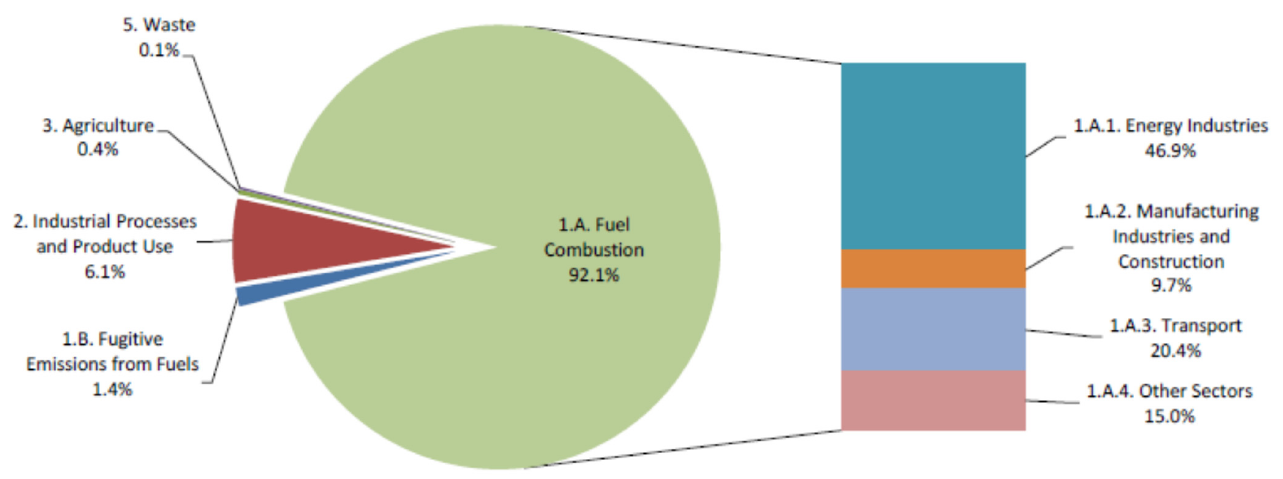
Figure 2. Carbon dioxide emission (in %) in Poland by sector (in 2019). Source: Poland’s National Inventory Report 2021 Greenhouse Inventory for 1988–2019 Submission under the United Nations Framework Convention on Climate Change and the Kyoto Protocol, National Centre for Emission Management (KOBiZE) at the Institute of Environmental Protection—National Research Institute, Warsaw 2021, p. 16.